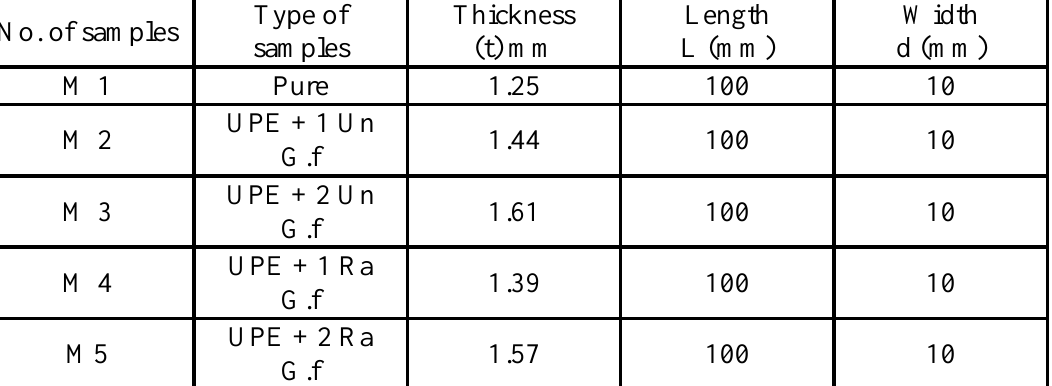
Table 2 : The type and number of reinforcing Layers of samples for unsaturated polyester/fiber glass composite.